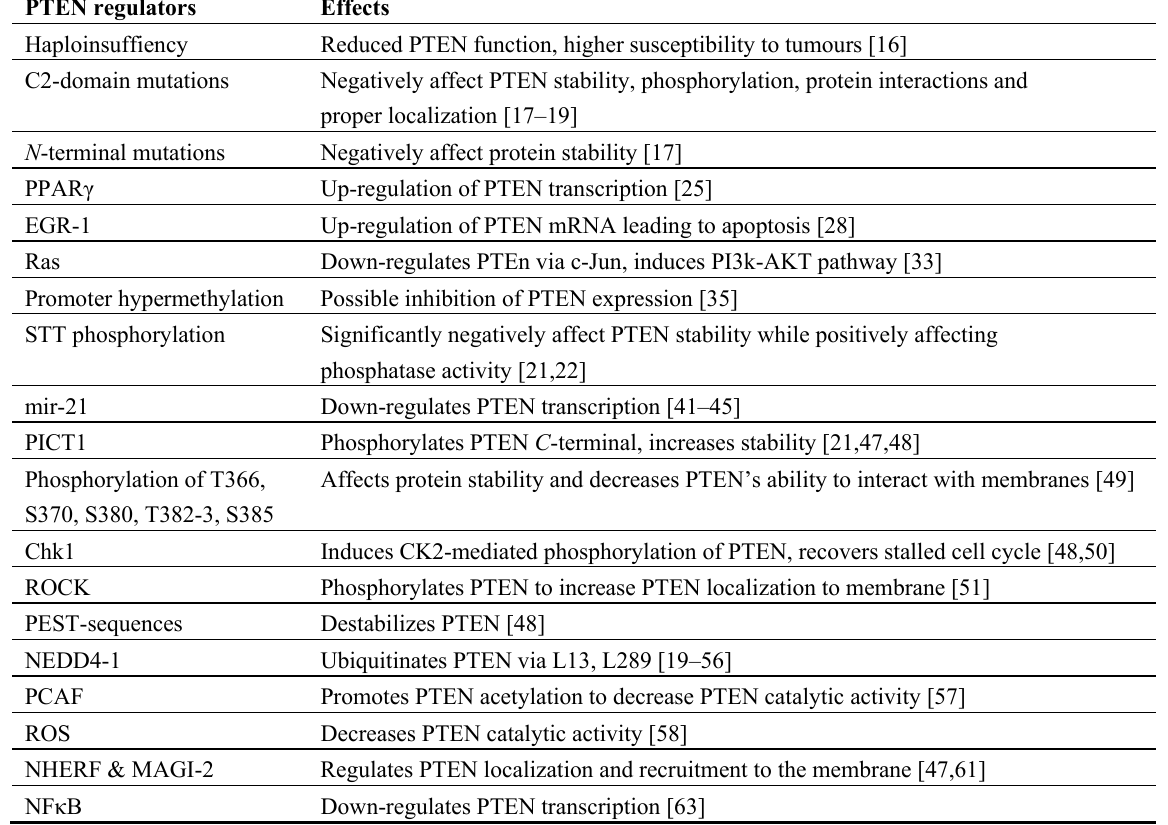
Table 1. Regulators of PTEN and their